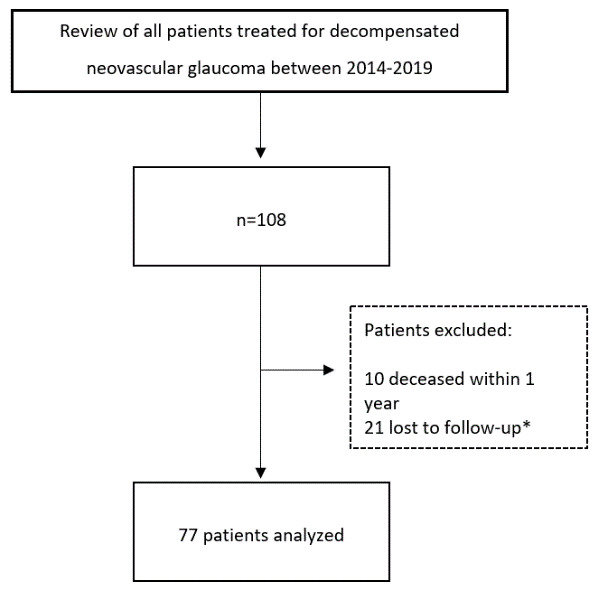
Flow chart.Eyes with no light perception and patients with a history of glaucoma other than neovascular glaucoma were excluded. *Telephone survey with all patients lost to follow-up.